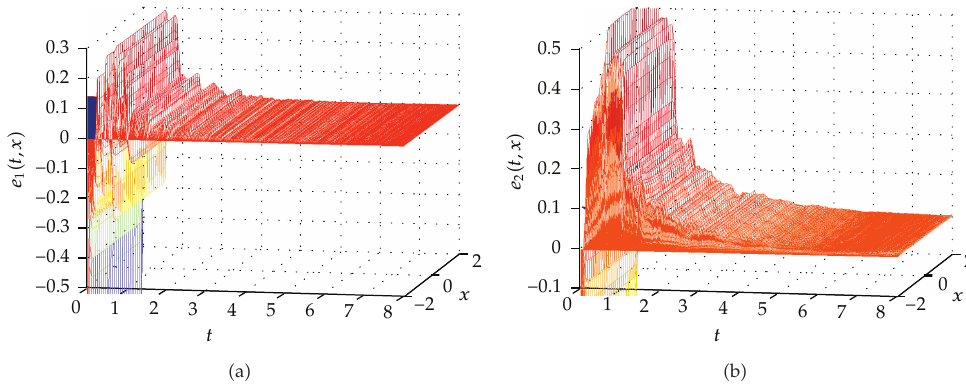
Figure 5: Dynamical behavior of synchronization errors e 1 (cid:6) t,x (cid:7) (cid:6) a (cid:7) and e 2 (cid:6) t,x (cid:7) (cid:6) b (cid:7)